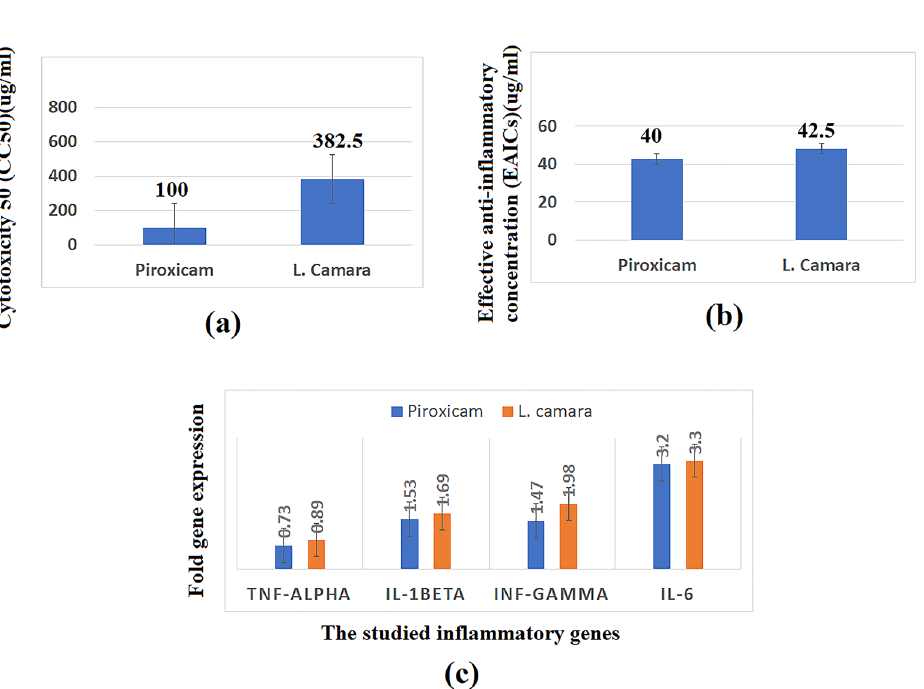
Figure 5. Bar chart showing ( a ) cytotoxicity (CC50 µg/mL), ( b ) effective anti-inflammatory concentrations (EAICS) (µg/mL) of L. camara extract and piroxicam, ( c ) TNF- α , IL-1 β , INF- γ , IL-6 (fold change in gene expression) by L. camara extract and piroxicam (standard anti-inflammatory